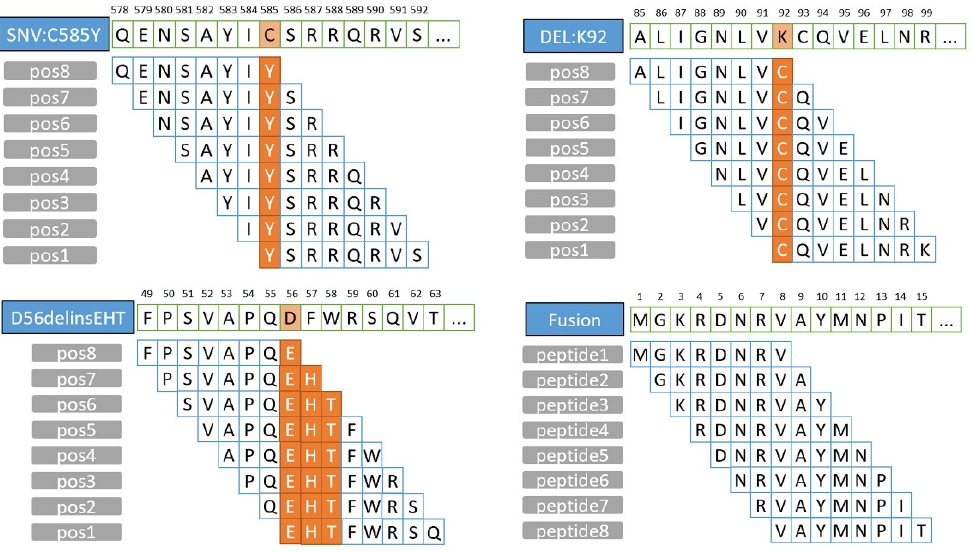
Figure 2. Schematic diagram of mutant peptides synthesis.